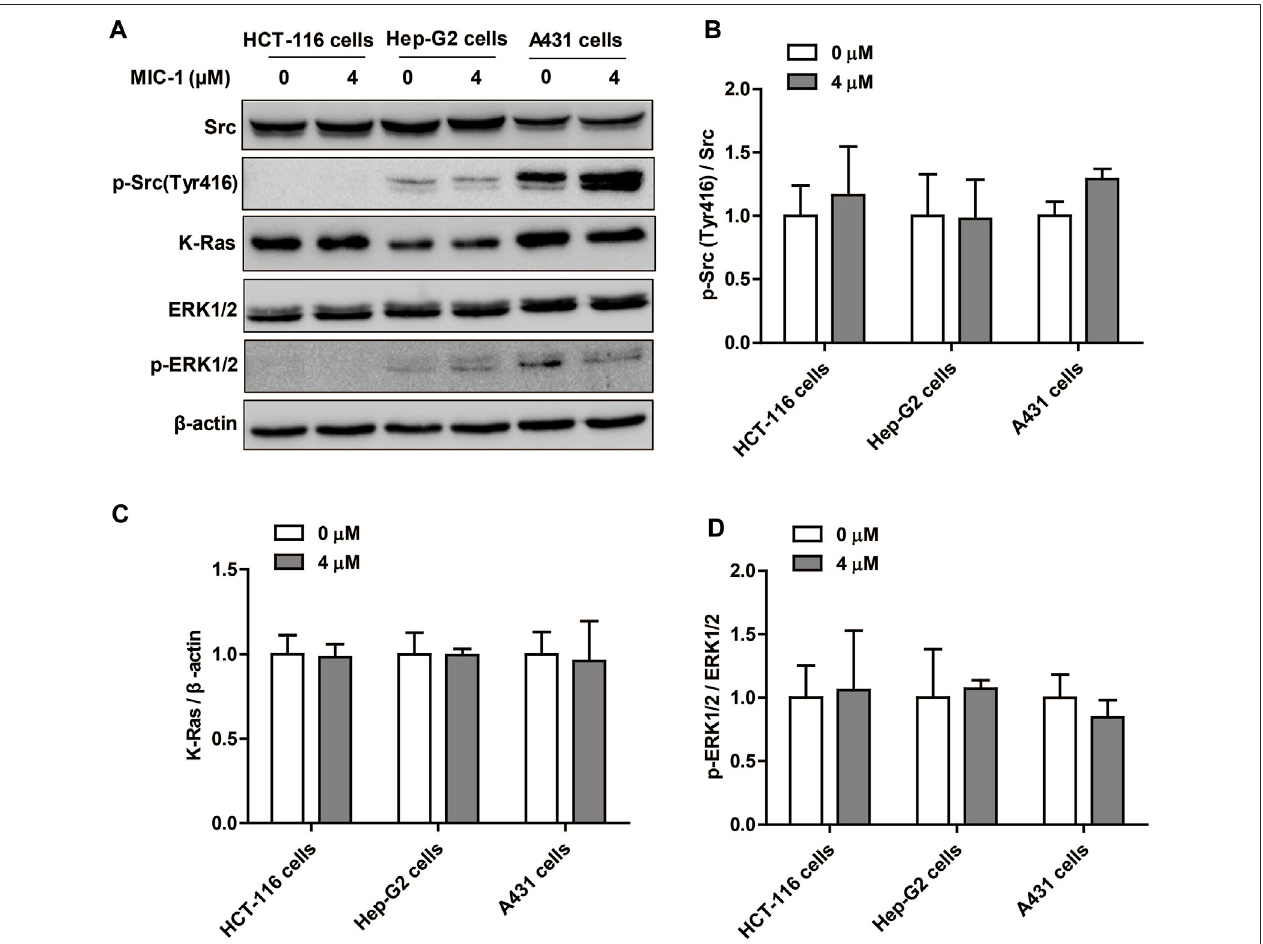
FIGURE7| EffectofMIC-1onPTP1B-relatedSrc/Ras/Raf/ERKsignalingpathwayinnon-renalcancercells. (A) HCT-116cells,Hep-G2cells,andA431cellswere treated withMIC-1(0 or 4 μ M) for 48h, and the expression ofSrc, p-Src (Tyr416),K-Ras, ERK1/2,and p-ERK1/2 was detected bywesternblotting. β -actin served asa loading control. Quanti fi cation of the relative levels of p-Src (Tyr416) (B) , K-Ras (C) , and p-ERK1/2 (D) ; each value was normalized to that of Src, β -actin, and ERK1/2, respectively. Values represent the means ± SEM from three independent experiments and statistical analysis was performed by unpaired two-tailed Student ’ s t